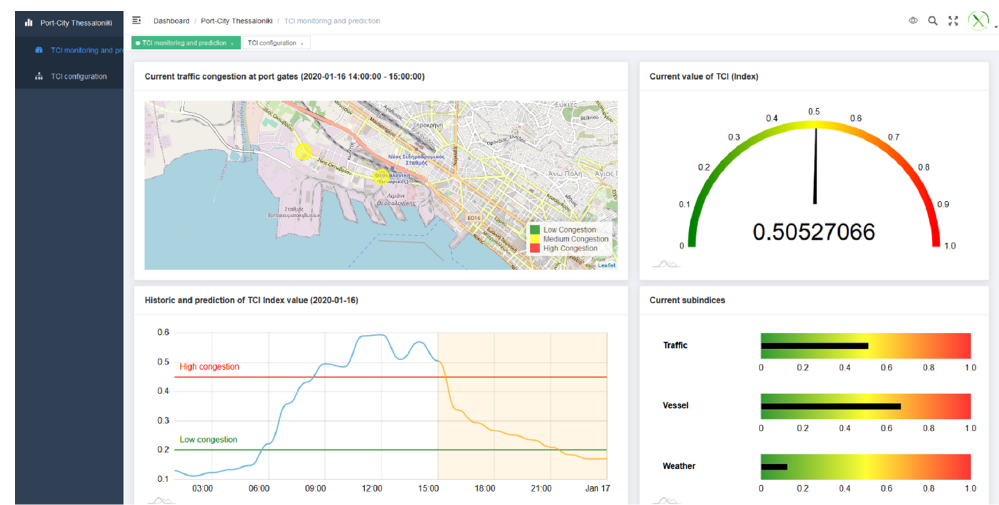
Figure A11. Visualization of the scenario 3.2 in the UI dashboard.